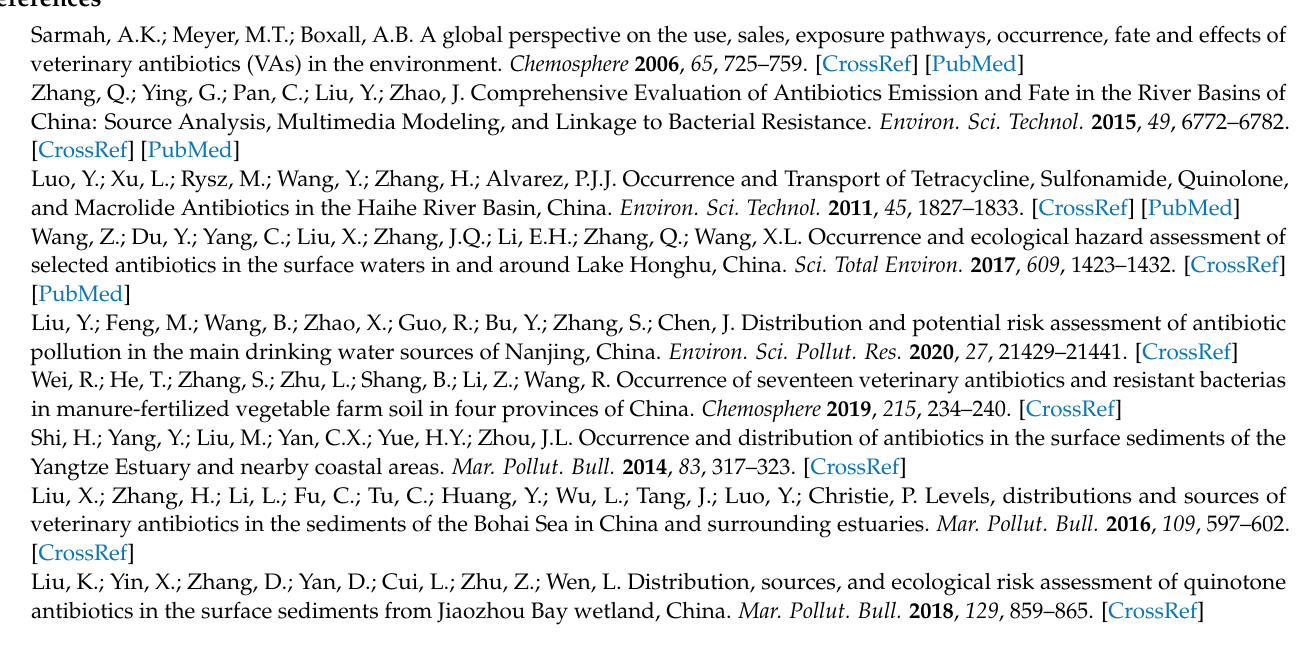
Table S3: Comparison of Langmuir adsorption coefficients (Kl), maximum adsorption capacities (Qm), Freundlich adsorption coefficients (Kf) and characteristic constants (n) of different adsorbents for TC